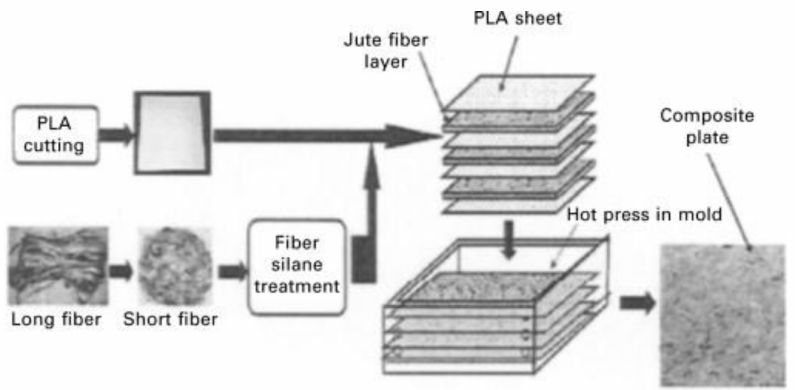
Figure 9. Fabrication procedure of jute fiber reinforced polymer composites [196]. Reproduced with